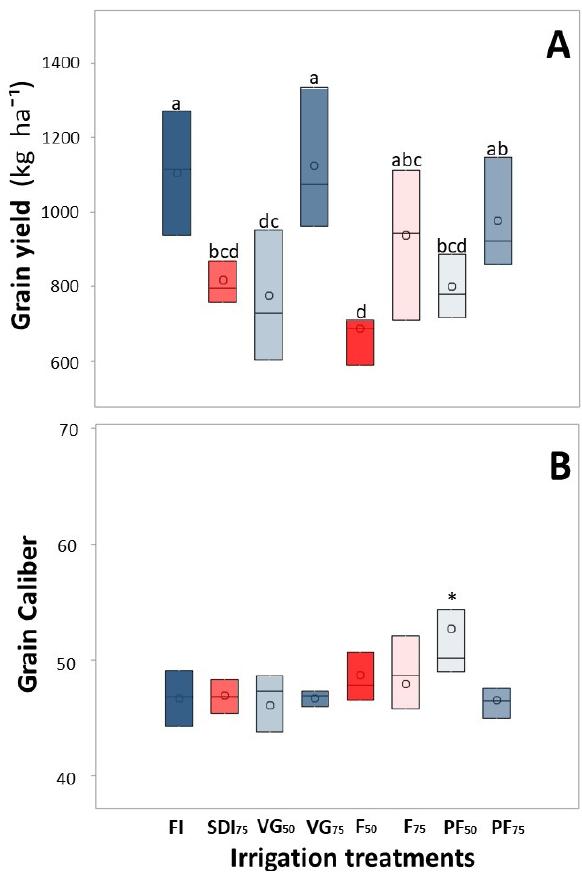
Figure 4. ( A ) Grain yield and ( B ) caliber (grains 30 g − 1 ) of chickpea grown using different irrigation treatments in Todos Santos, Baja California Sur, Mexico. Vegetative growth (VG), flowering (F), and pod-filling (PF) stages. RDI = regulated deficit irrigation. FI = full irrigation application of 100% ETc during VG, F, and PF. SDI 75 = sustained deficit irrigation applying 75% of ETc during VG, F, and PF. VG 50 = RDI applying irrigation equivalent to 50% of ETc in VG. VG 75 = RDI applying irrigation equivalent to 75% of ETc in VG. F 50 = RDI applying irrigation equivalent to 50% of ETc in F. F 75 = RDI applying irrigation equivalent to 75% of ETc in F. PF 50 = RDI applying irrigation equivalent to 50% of ETc in PF. PF 75 = RDI applying irrigation equivalent to 50% of ETc in PF. abcd : di ff erent le tt ers among treatments indicate signi fi cant di ff erence ( p ≤ 0.05, LSD). More intense blue color in box plot indicates higher total irrigation volume, and more intense red color in box plot indicates lower total irrigation volume. Table 6. Di ff erences (%) in grain yield (GY) and caliber (Cal) among irrigation treatments.